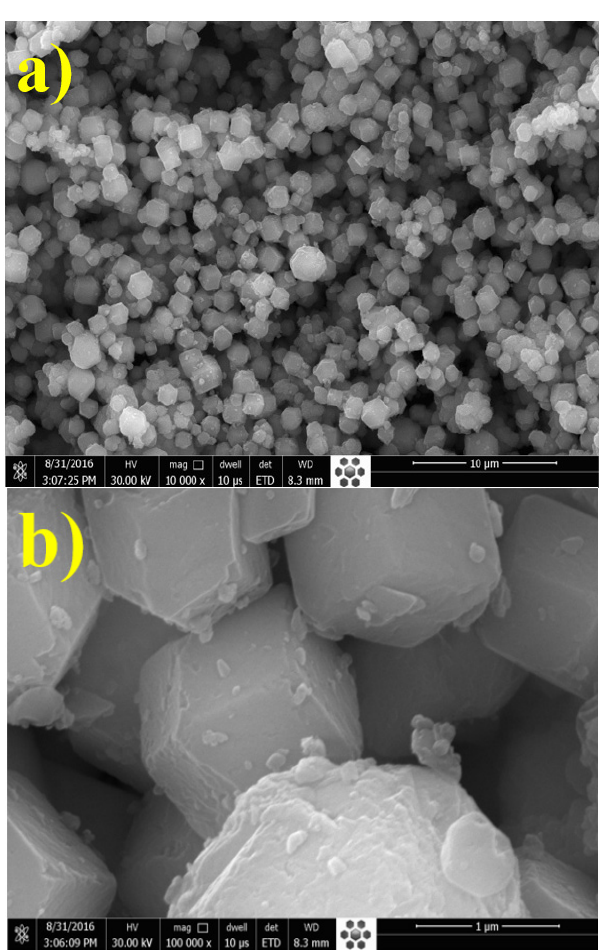
Figure A6. SEM morphology of the as-synthesized MOF UiO-66 particles: ( a ) morphology with 10,000x magnification, ( b ) a zoom-in observation of UiO-66 morphology with 100,000× magnification.